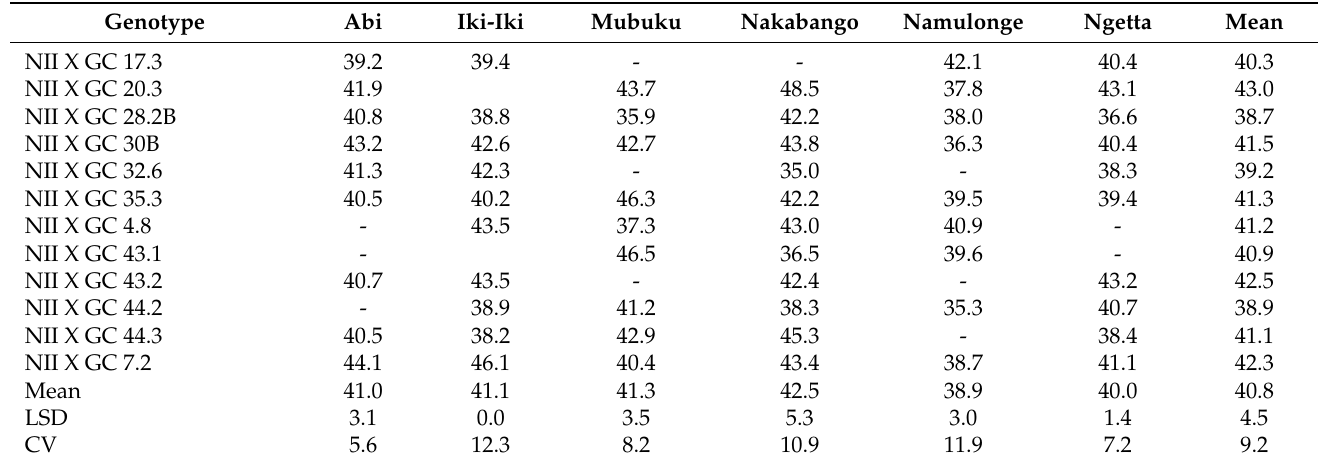
3.2. Which-Won-Where Patterns and Stability of Genotypes for Protein Content The genotype and genotype × Location interactions for the traits were visualized in Ranking GGE, “Which-Won-Where” GGE, and the discriminating and representative environment GGE biplot analysis, as represented in Figures 2–4. The GGE biplots explained 60.21% of the total interaction variations, distributed as 34.77% and 25.44% between prin- cipal component (PC)1 and PC2, respectively. Genotype NII X GC 7.2 had a high protein content and was very stable across the six locations (Figure 2). This genotype was the high- est performer, as it was furthest from the mean along the “average environment axis” [32]. The biplot showed that most of the genotypes’ protein contents did not deviate much from 4). Namulonge was the most representative of the test locations compared to the rest due the mean (Figure 2).